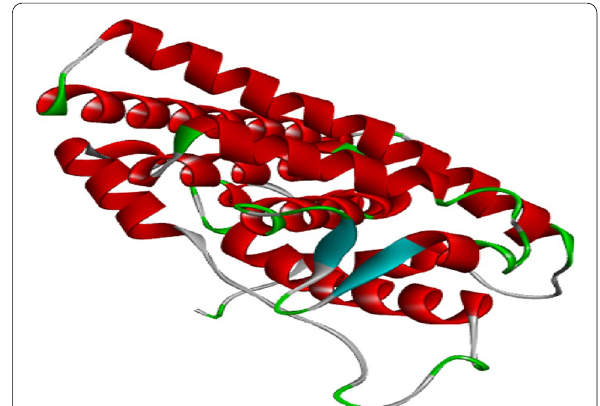
Fig. 9 3D structure of the prepared ER + receptor